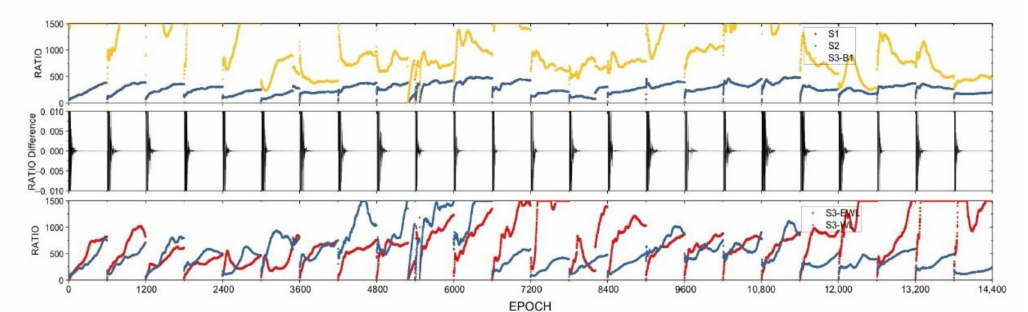
Figure 3. Time series of ambiguity-fixing indicator RATIO of the fixing scheme S1 and S2 ( top ), and their differences ( middle ), and that of EWL and WL fixing of S3 ( bottom ), the RATIO of B1 fixing in S3 is also shown at the top panel for the BDS-TF solutions of Baseline A in static